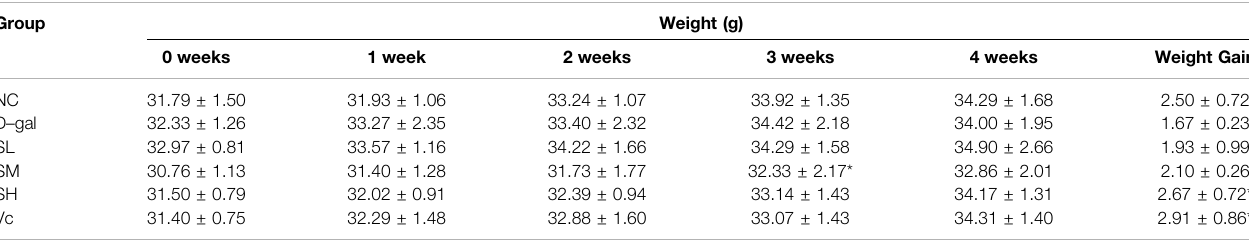
TABLE 4 | Changes in body weight during feeding. Group